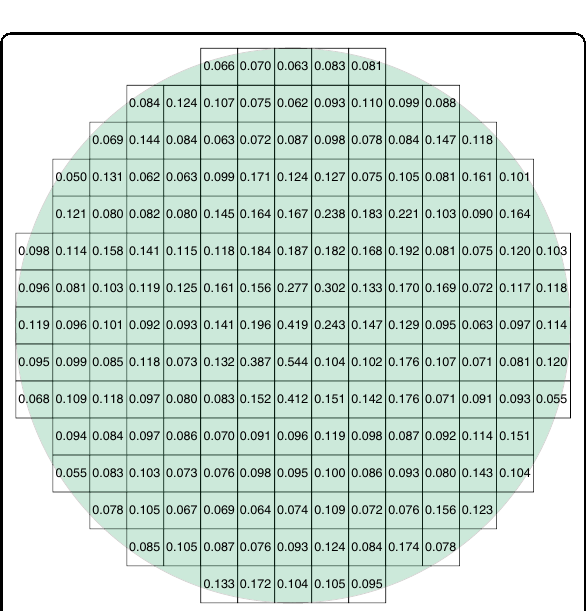
Fig. 4 The LTV distribution of 6-inch n-type SiC